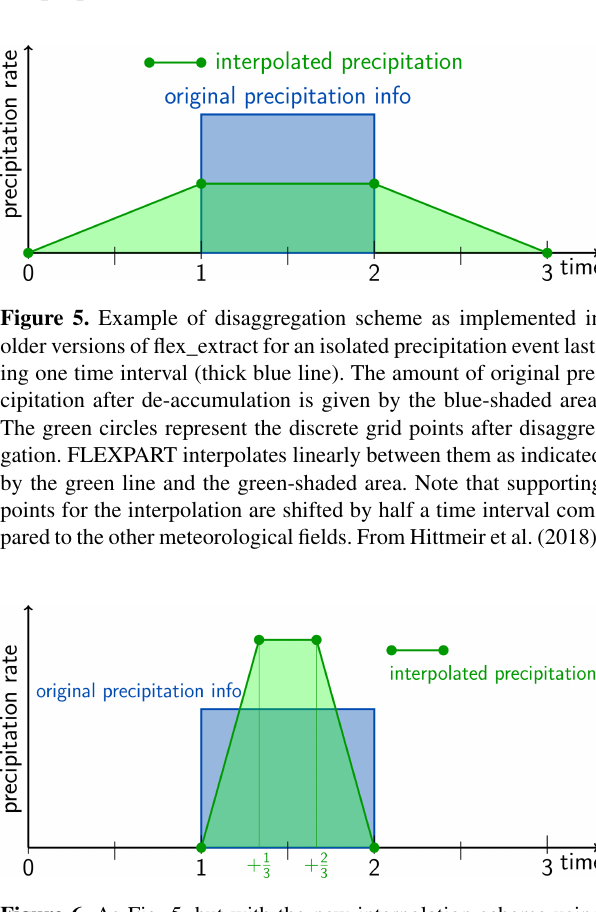
Figure 6. As Fig. 5, but with the new interpolation scheme using additional subgrid points. From Hittmeir et al.